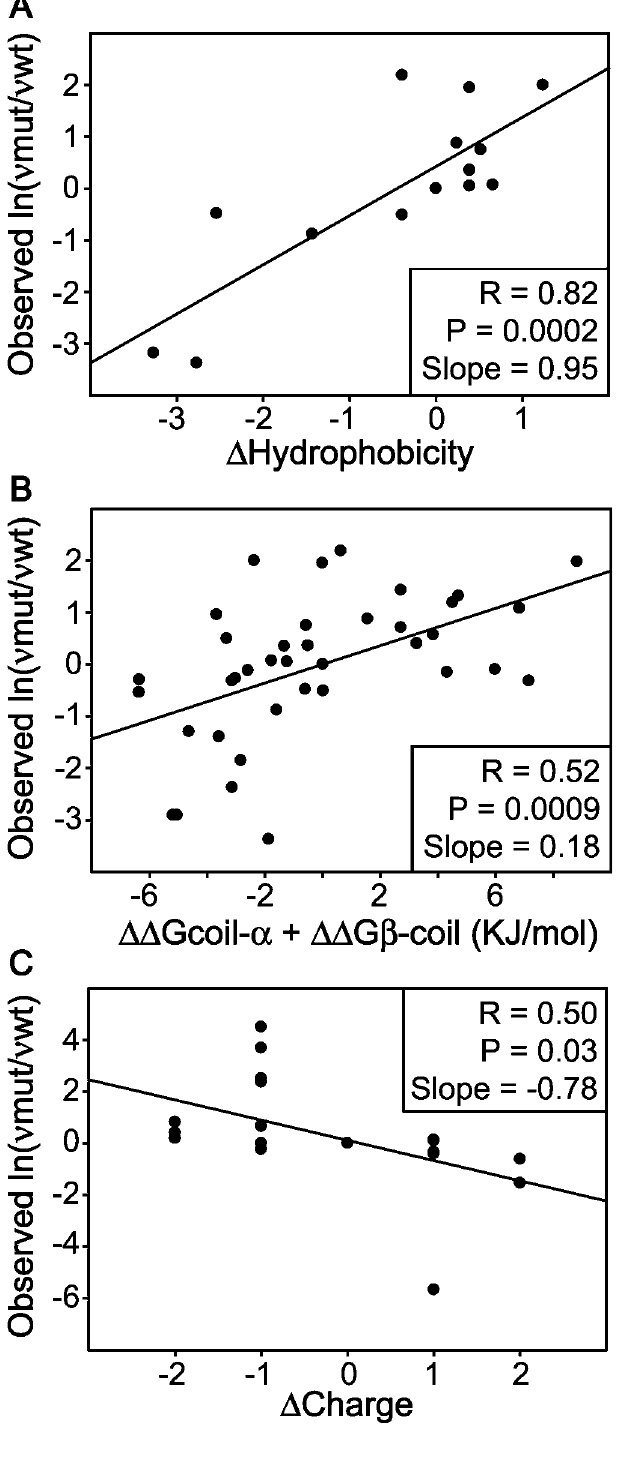
Figure 2. Rederivation and Validation of the Chiti–Dobson Equation The original Chiti–Dobson equation was rederived by correlating all known empirically measured mutation-related changes in protein aggregation rates as of 2005 with the corresponding changes in the physicochemical properties of charge, hydrophobicity, and secondary structure. Importantly, aggregation rate data were not taken directly from the publication that presented the Chiti–Dobson equation; instead these values were calculated from their respective original publication if applicable (Table 4). The dependence of observed ln( m mut / m wt )